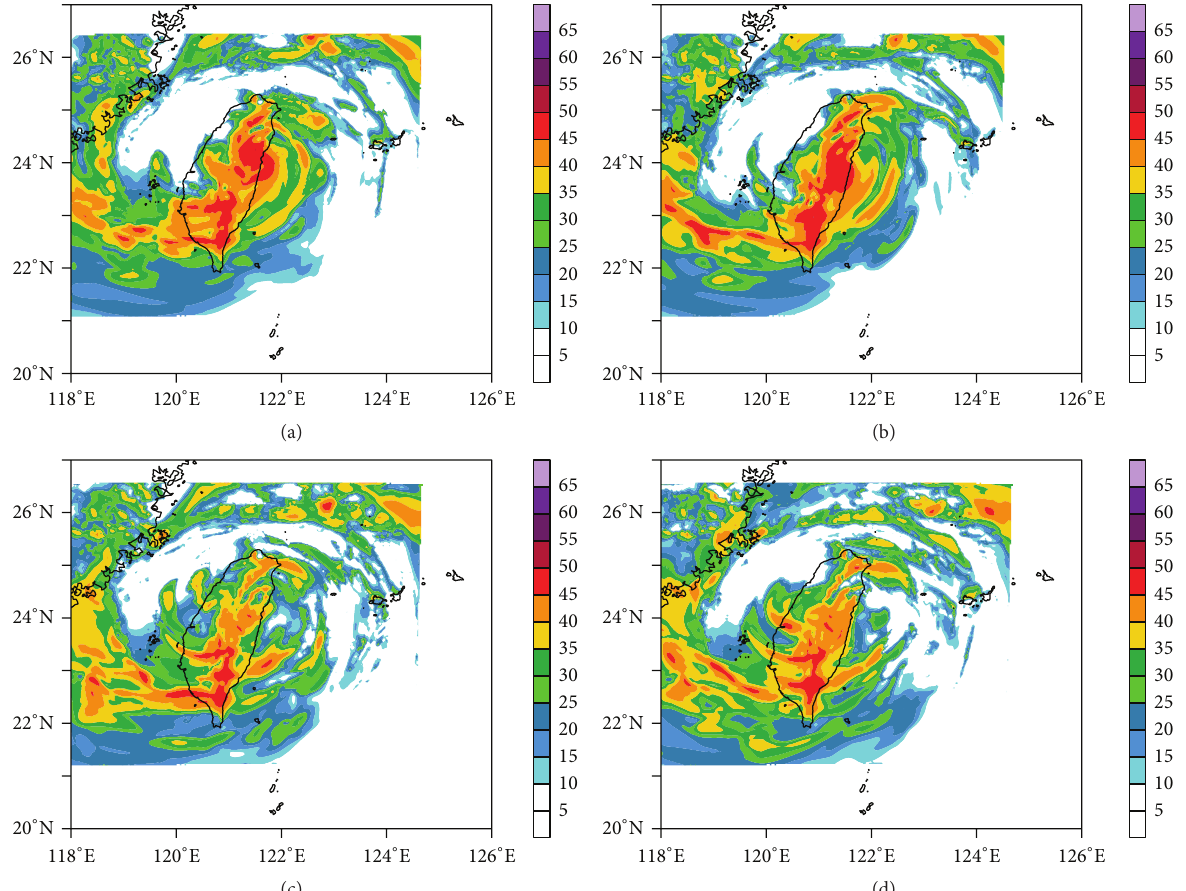
Figure 6: Horizontal maps of the simulated radar reflectivity from (a) CTRL, (b) No hflux, (c) No qflux, and (d) No flux at 1200 UTC 18 July